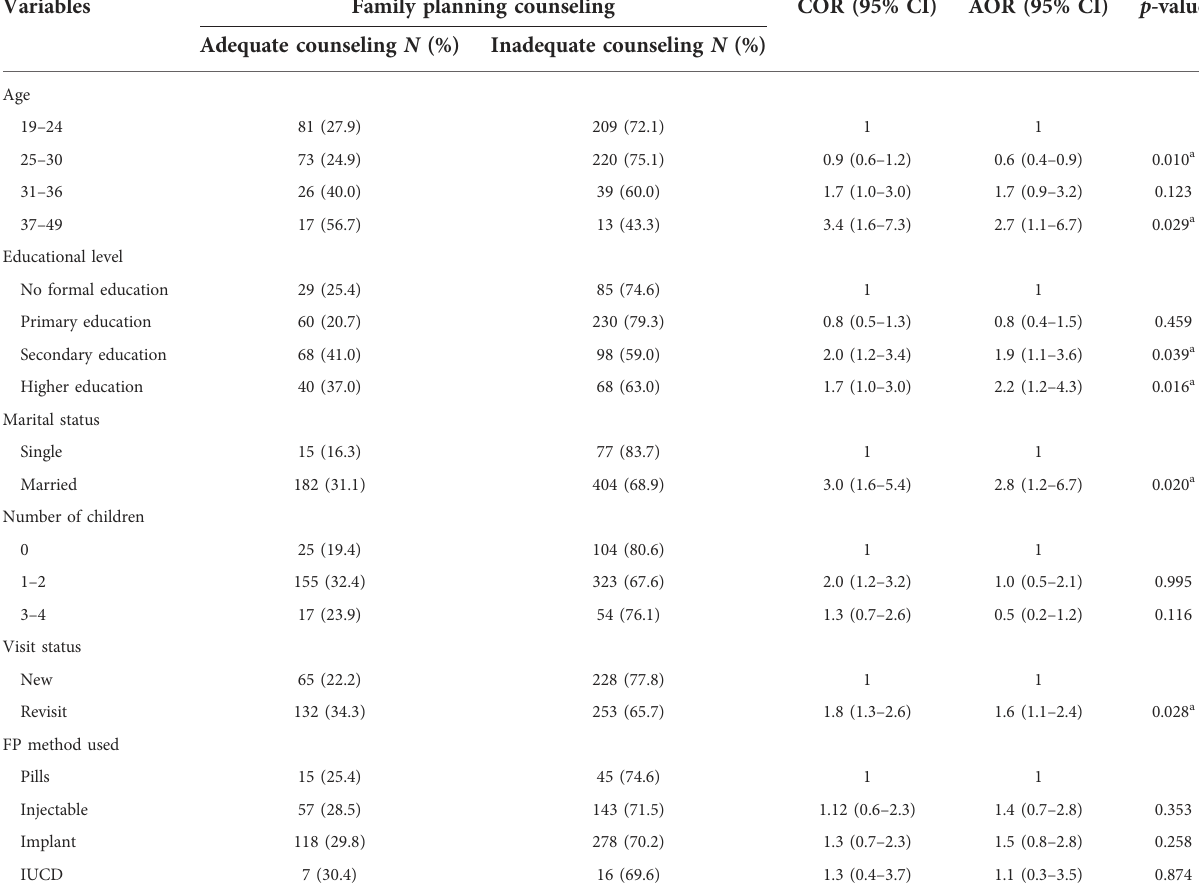
TABLE 4 Factors associated with inadequate family planning counseling among women attending family planning services at health facilities in Akaki Kality sub-city, Addis Ababa, Ethiopia,